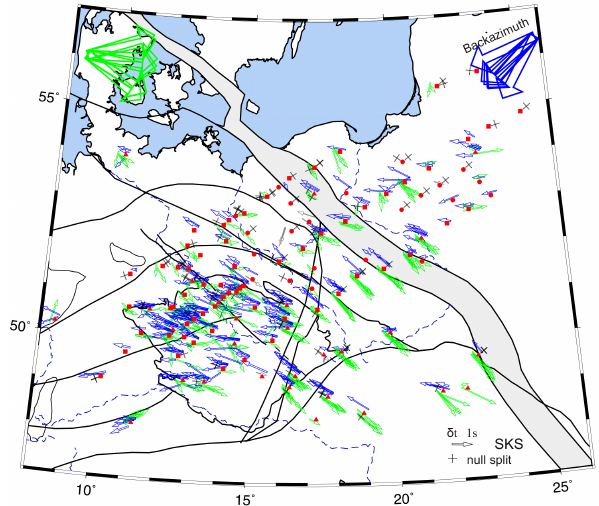
Figure 7. Fast shear-wave polarizations ( ψ , δt ) evaluated in the LQT coordinate system presented at ray-piercing points at depth of 80km. The arrows mark azimuths ϕ of the polarized fast split shear waves and point in down-dip directions. See also Fig. 3 and related text.